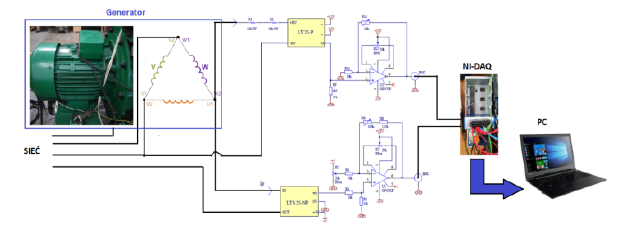
Fig. 4. Connection of the HASS 50-S current transducer with a test bench